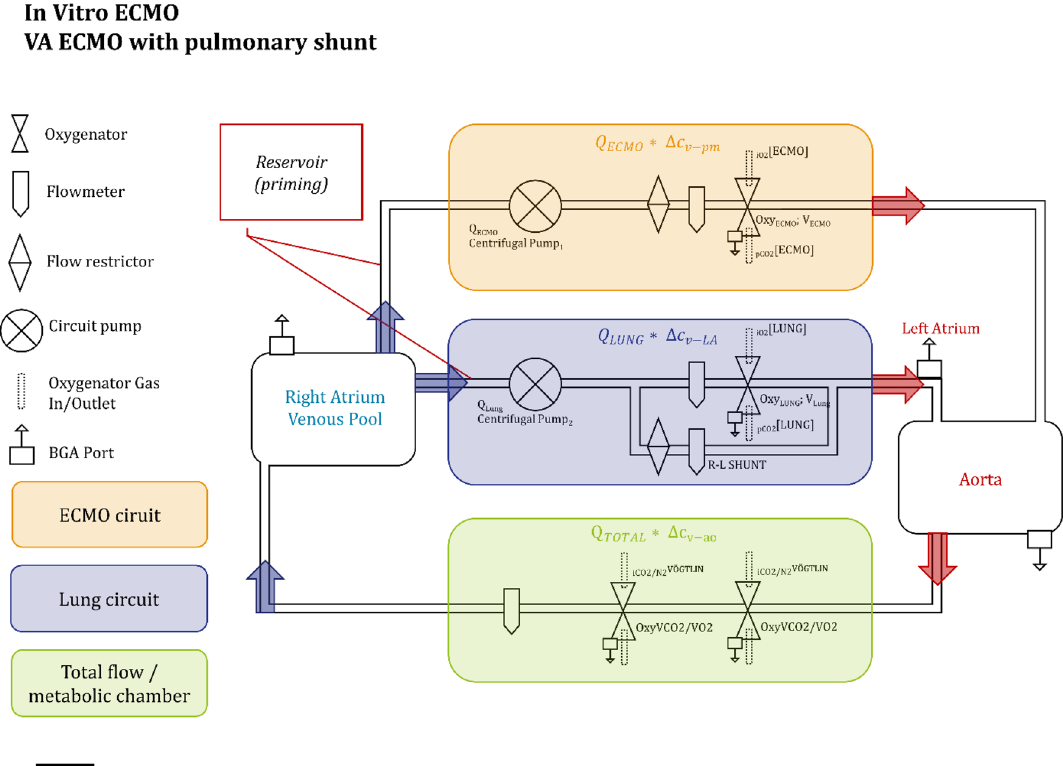
Figure 1. In-vitro lung/ECMO simulation. The in-vitro simulation consists of two parallel circuits (ECMO and lung) with the ability to shunt Oxy Lung . Blood samples could be drawn after Oxy ECMO (post membrane), after Oxy Lung (post lung), from the left atrium (LA), the aorta as well as the right atrium